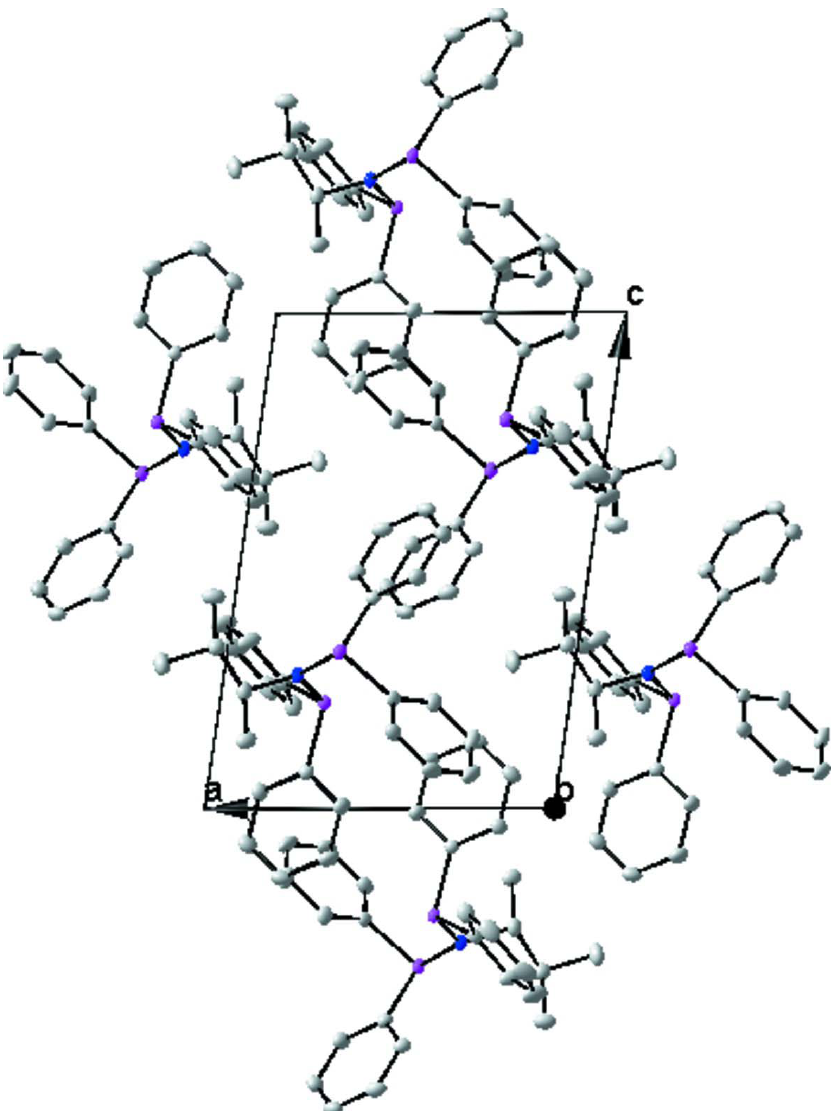
A view of (I) illustrating the disordered part of the